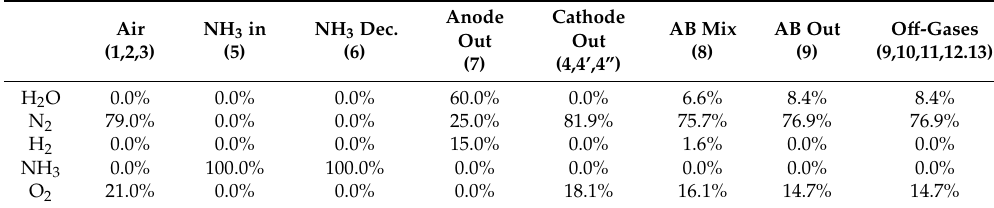
Table 11. Outputs parameters values of system in nominal conditions.